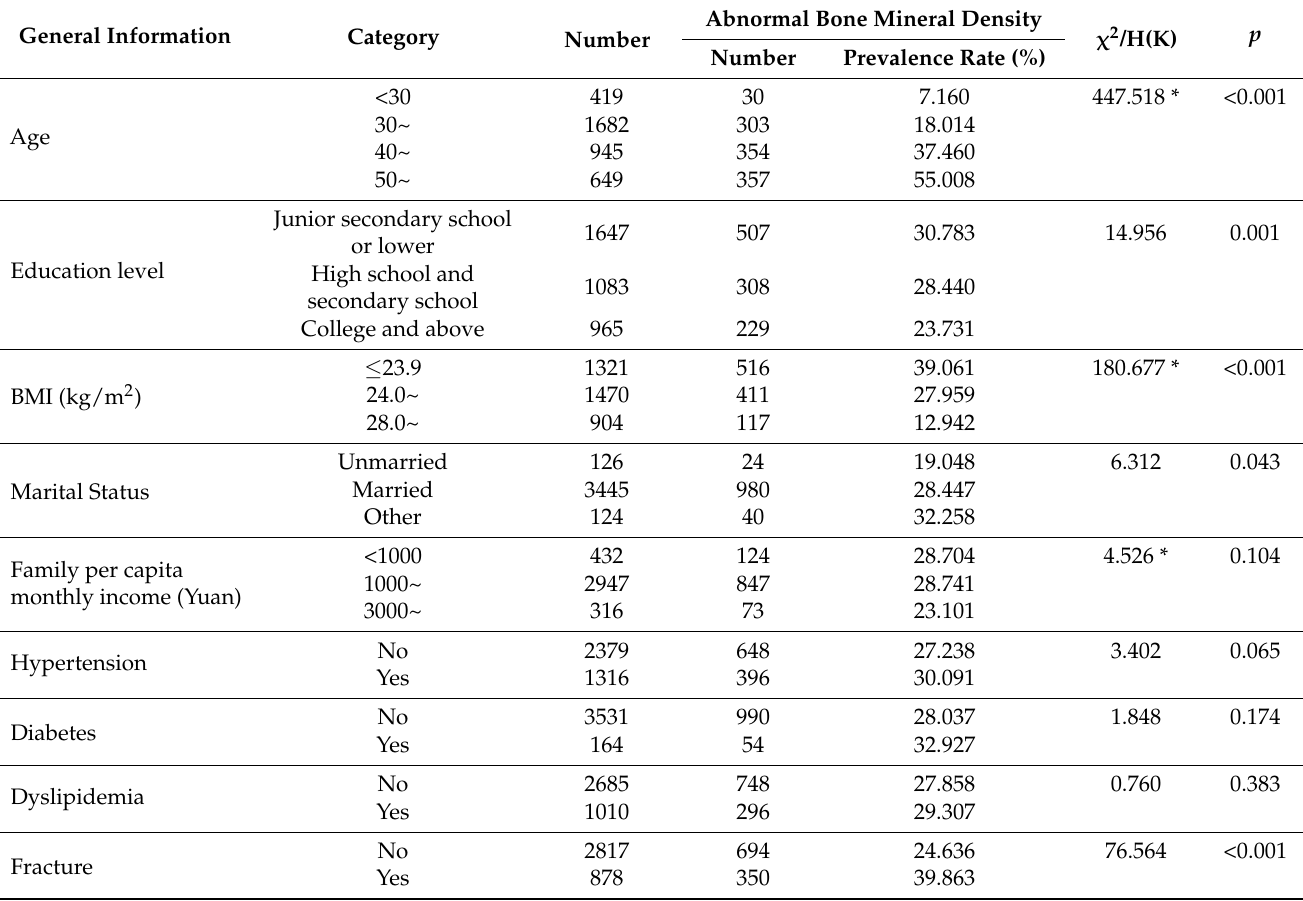
Table 2. General situation of male workers in coal